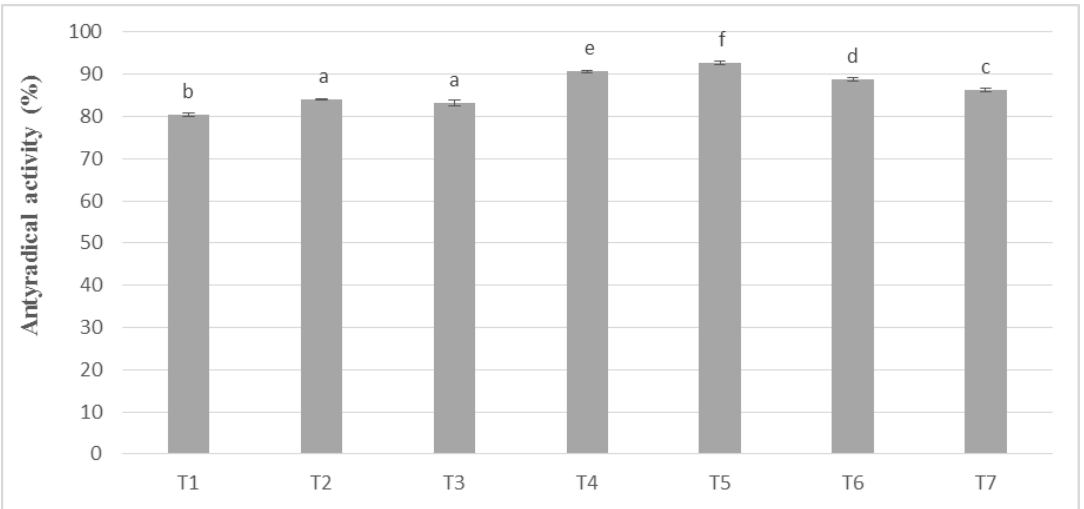
Figure 4. Antioxidant activity in chocolate milk masses prepared from unroasted cocoa liquor from Peru (the same letter means that there are no statistically significant differences between the analyzed products at a confidence level of α = 0.05; the abbreviations used in the graph are described in Table